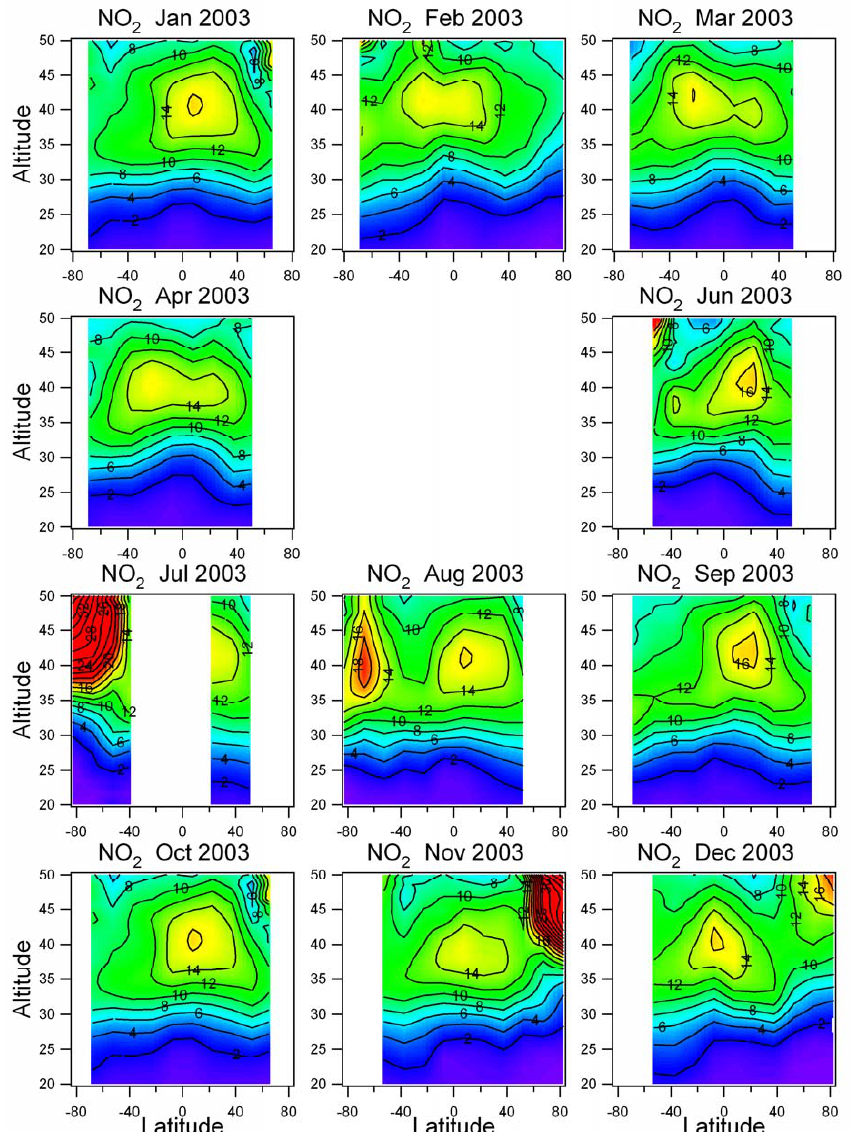
Fig. 30. Latitude-altitude maps of NO 2 mixing ratio in ppbv for each month in 2003. A malfunction of the pointing mechanism occurred in May 2003. There are strong increases of NO 2 in July 2003 in the south polar region, and in November 2003 in the north polar region, caused by the descent of air carrying NO molecules in the polar night (from Hauchecorne et al., 2005a).